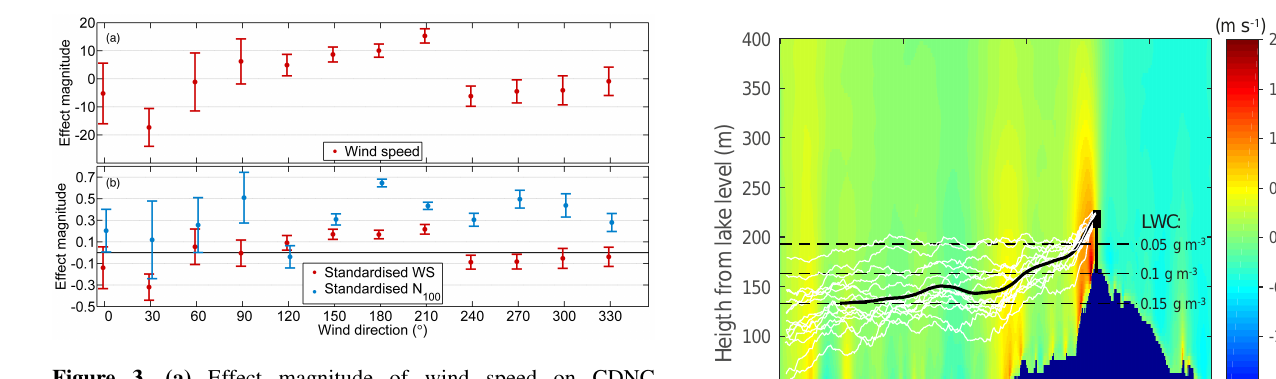
Figure 3. (a) Effect magnitude of wind speed on CDNC ( ∂ CDNC /∂v ) for different wind direction intervals and (b) stan- dardised effect magnitude of wind speed and N 100 on CDNC.